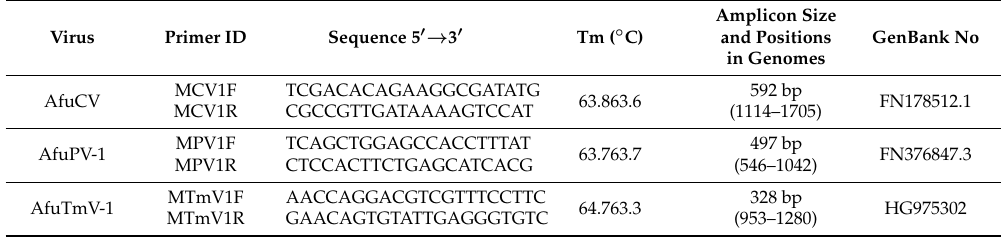
Table 1. Oligonucleotide primers used for multiplex polymerase chain reaction (PCR) to detect virus infection in A. fumigatus . AfuCV: Aspergillus fumigatus chrysovirus; AfuPV-1: Aspergillus